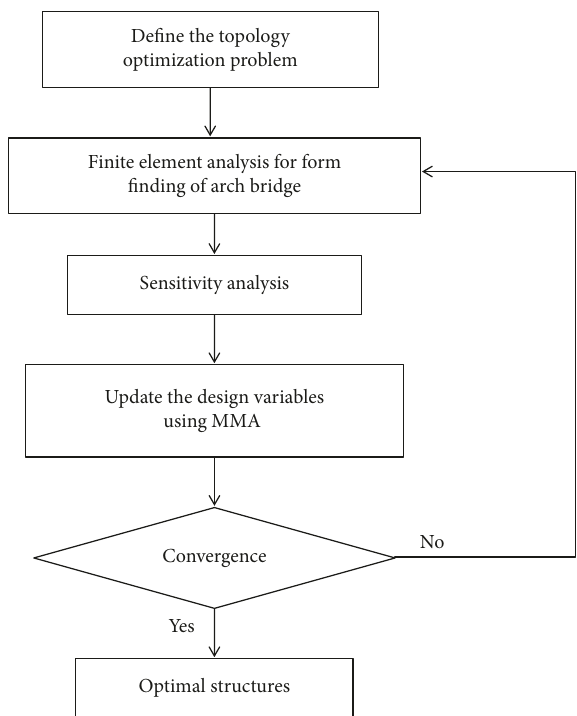
Figure 1: Flowchart of form finding of arch